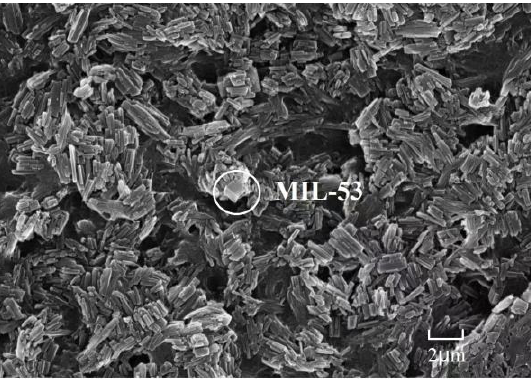
Figure 4. SEM images of MIL-53 MMM with the plotting scale of 2 μm.